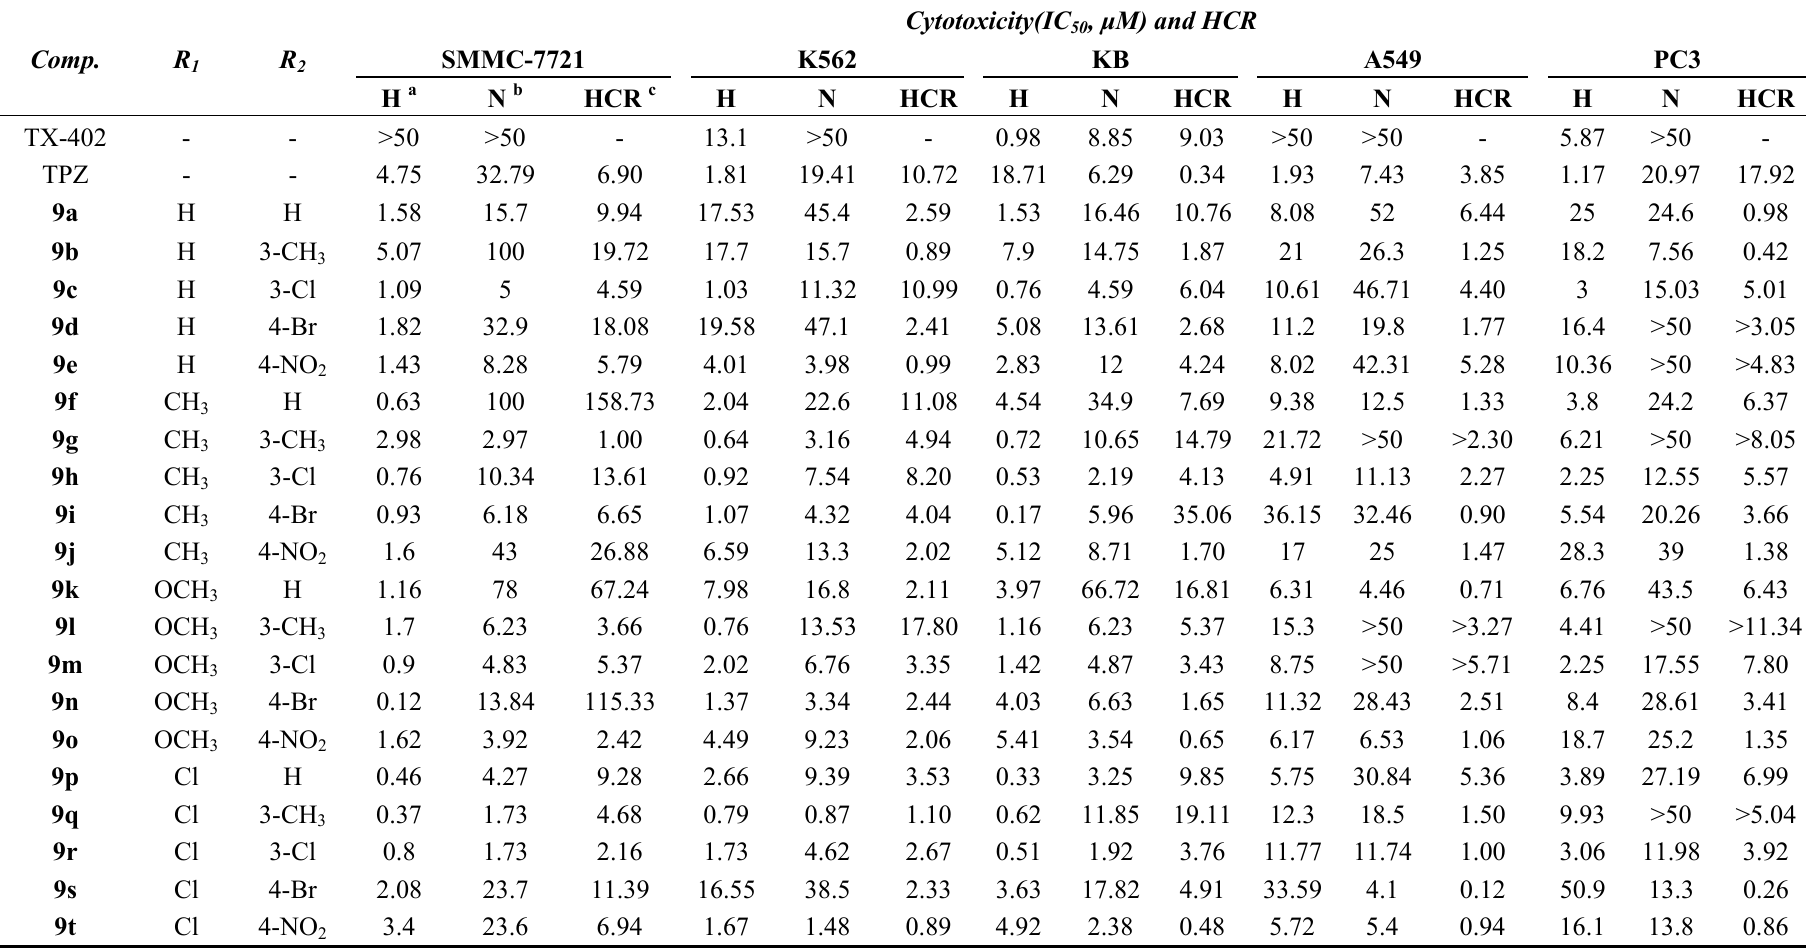
Table 1. Cytotoxicity of 2-cyano-3-aryl-quinoxaline 1,4-dioxides against five cancer cell lines in hypoxia and in normoxia.